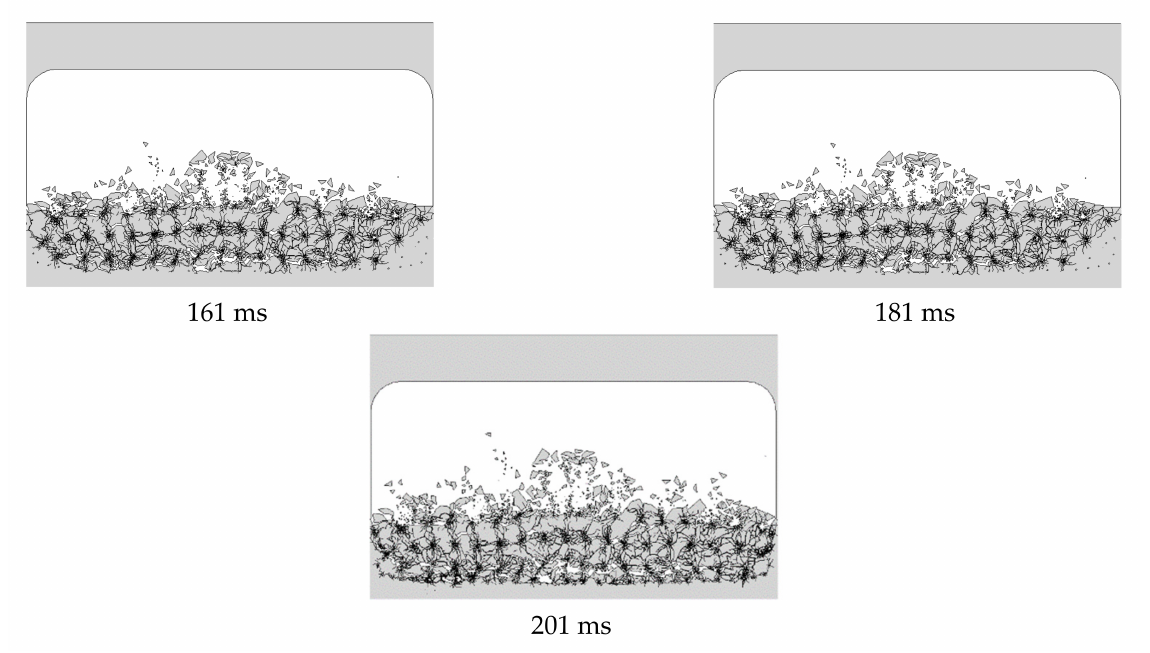
Figure 12. The fracture and fragmentation process of rock damage and fracture in the reserved core soil method.